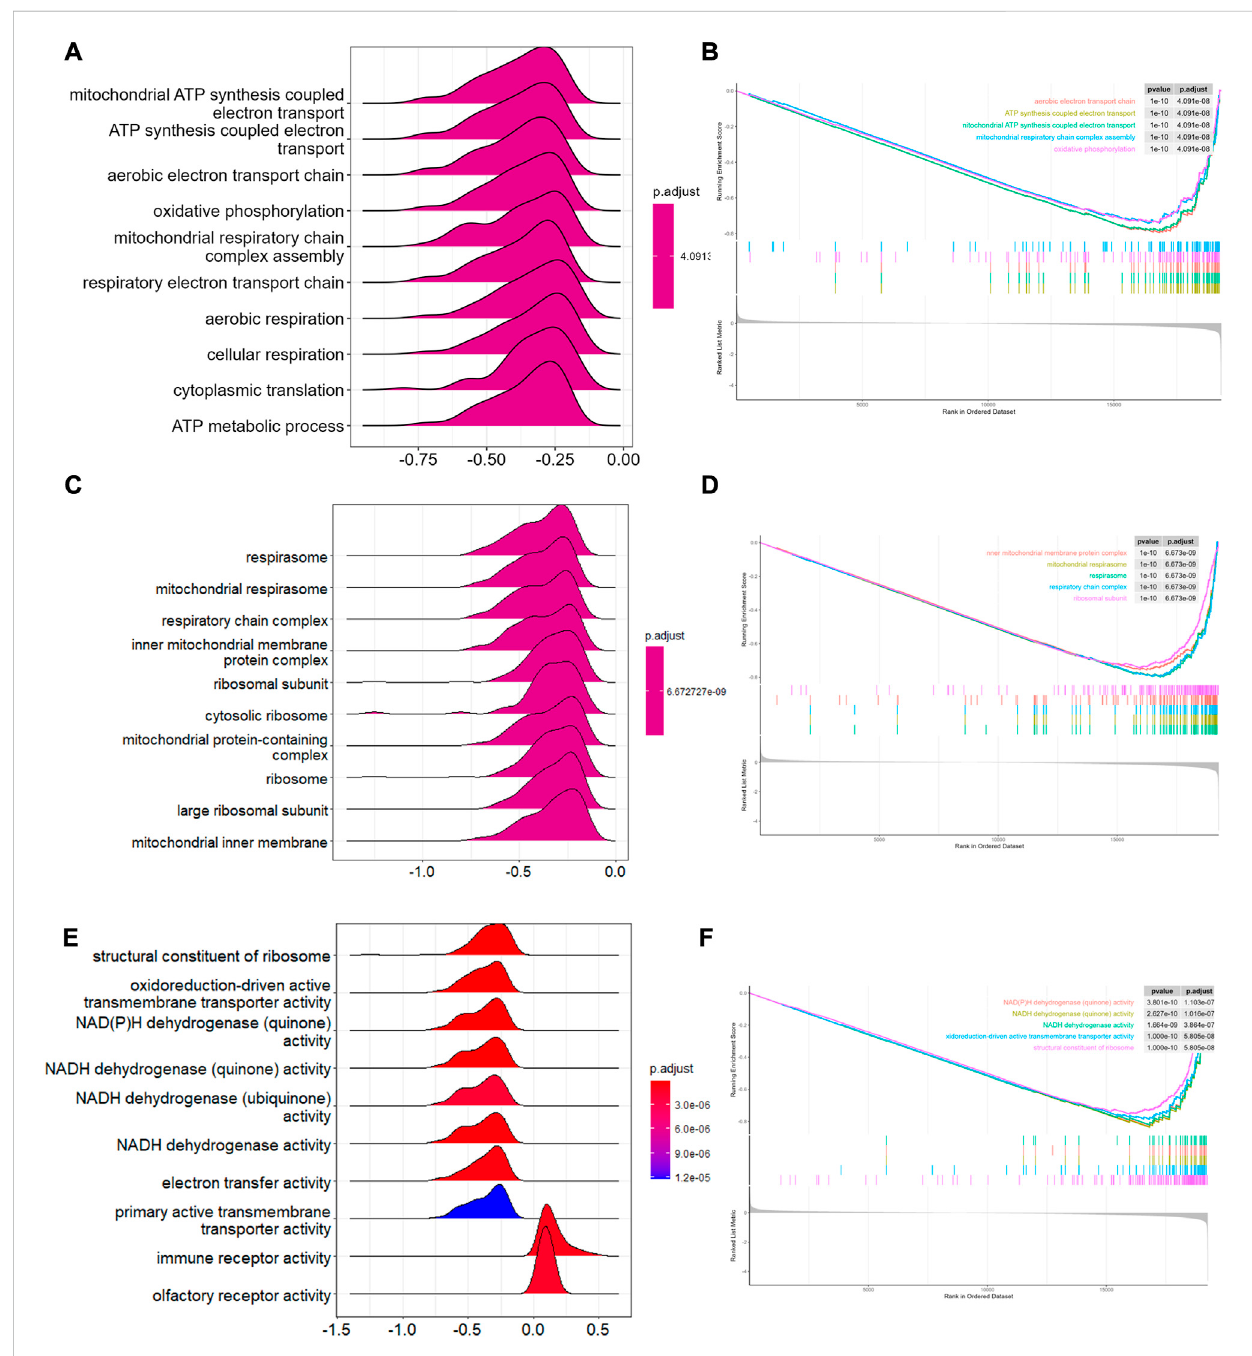
FIGURE 2 GSEAinT2-lowandT2-highasthma.RidgeplotsshowingGSEAenrichedin (A) BP, (C) CC, (E) MF;Top5pathwaysofGSEAenrichedin (B) BP, (D) CC, (F)